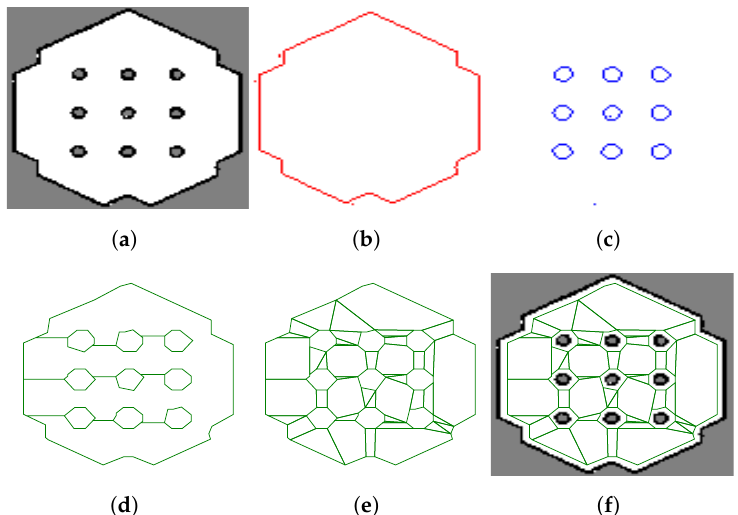
Figure 2. Illustration of the procedure for creating a polytope map from a standard grid map. ( a ) Occupancy grid map; ( b ) free space boundary extraction; ( c ) obstacle boundaries extraction; ( d ) free region with holes; ( e ) partition of free region into connected polytopes; ( f ) polytope map versus occupancy grid